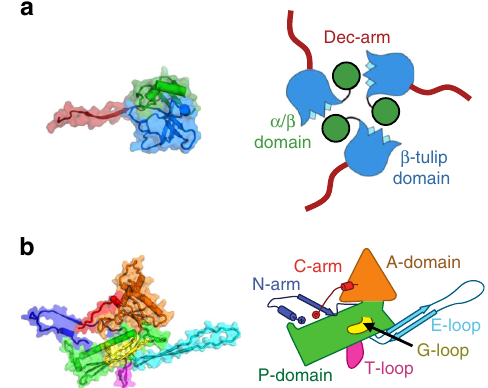
Fig. 3 Structural models of P74-26 MCP and Dec. a Structure of P74-26 Dec protein monomer colored by domain (left) with corresponding schematic of the Dec trimer (right). b Structure of P74-26 MCP colored by domain (left) with corresponding labeled schematic (right)